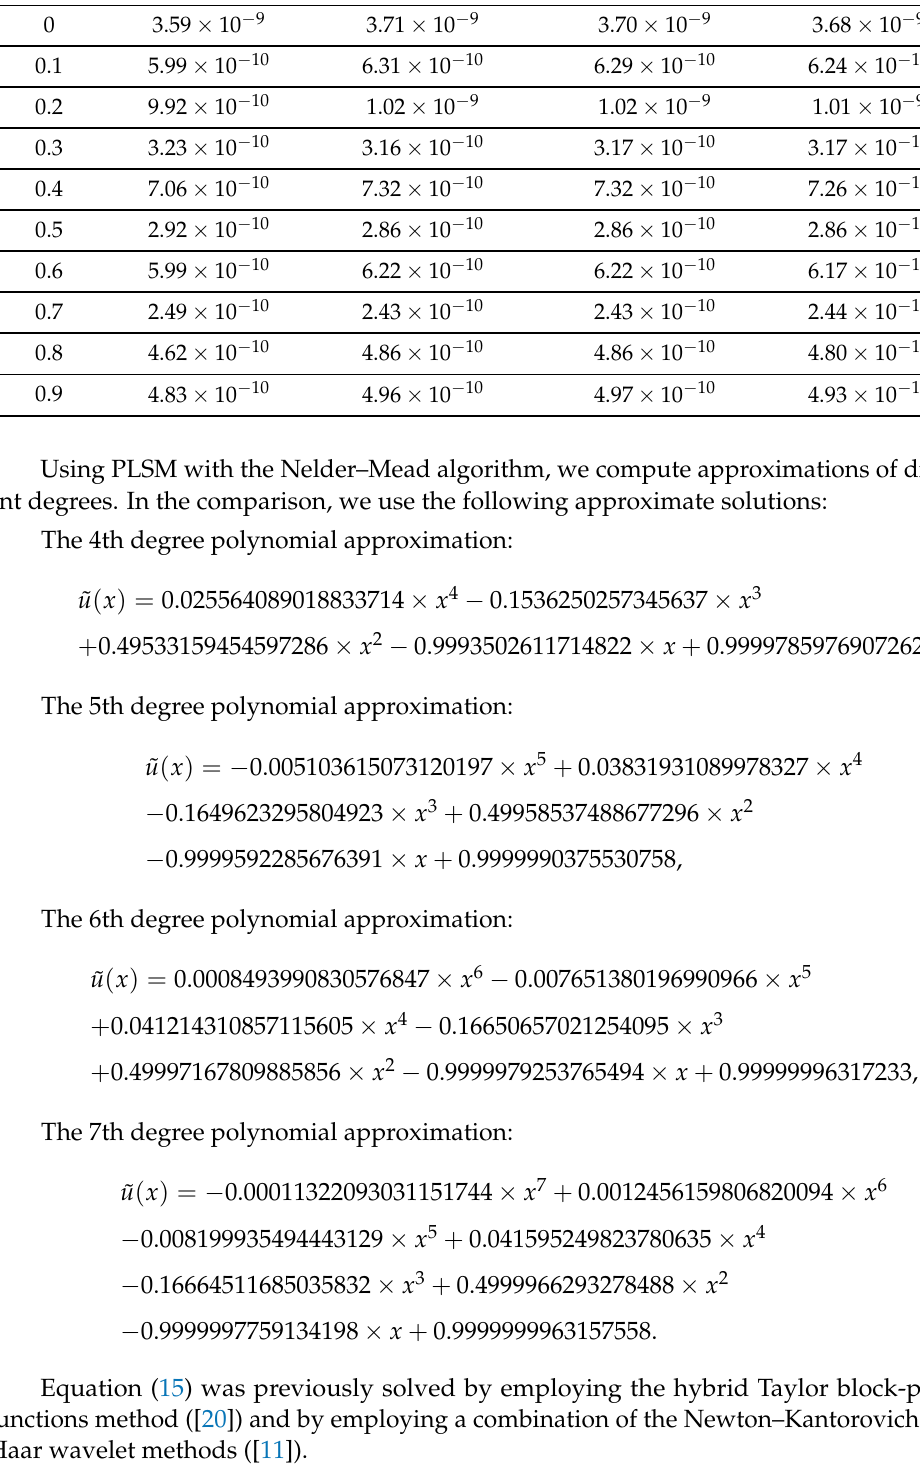
Table 2. Absolute errors of the 7th degree approximations for problem (15) corresponding to different optimization methods.